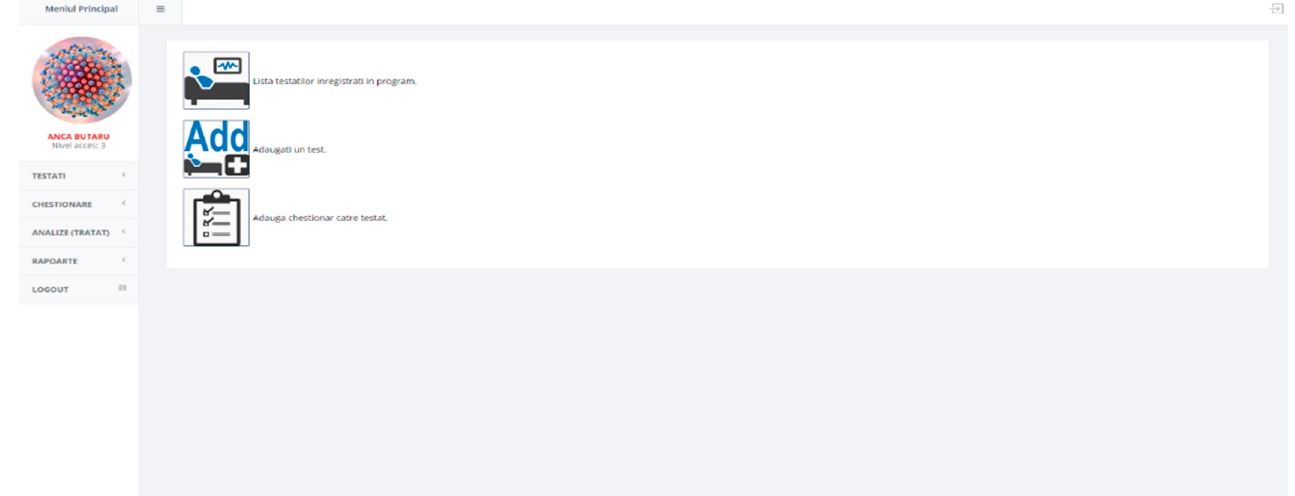
Figure 2. Online platform where each tested patient was recorded.